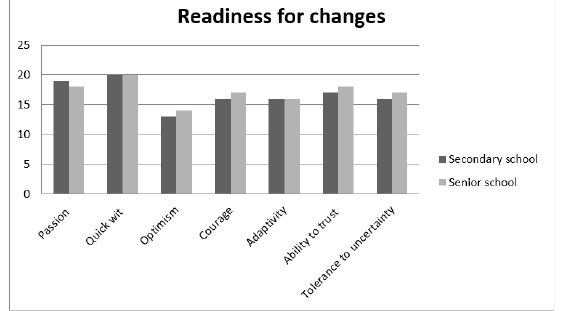
Figure 3. The results of enquiry on the technique “Personal readiness for